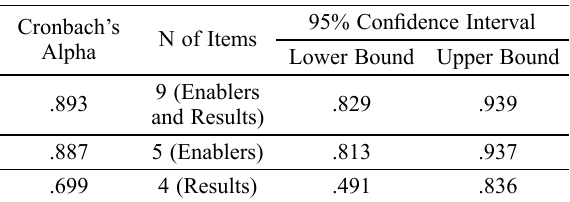
Table 3. Cronbach’s alpha and 95 per cent confidence limits for each construct